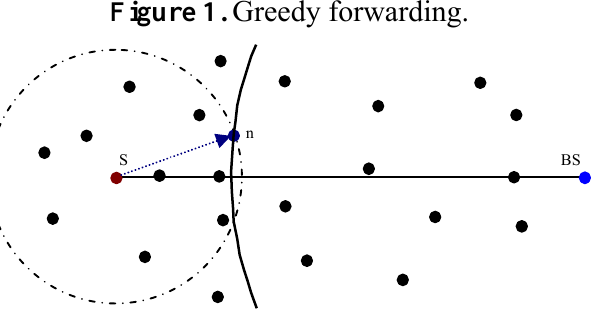
Figure 1. Greedy